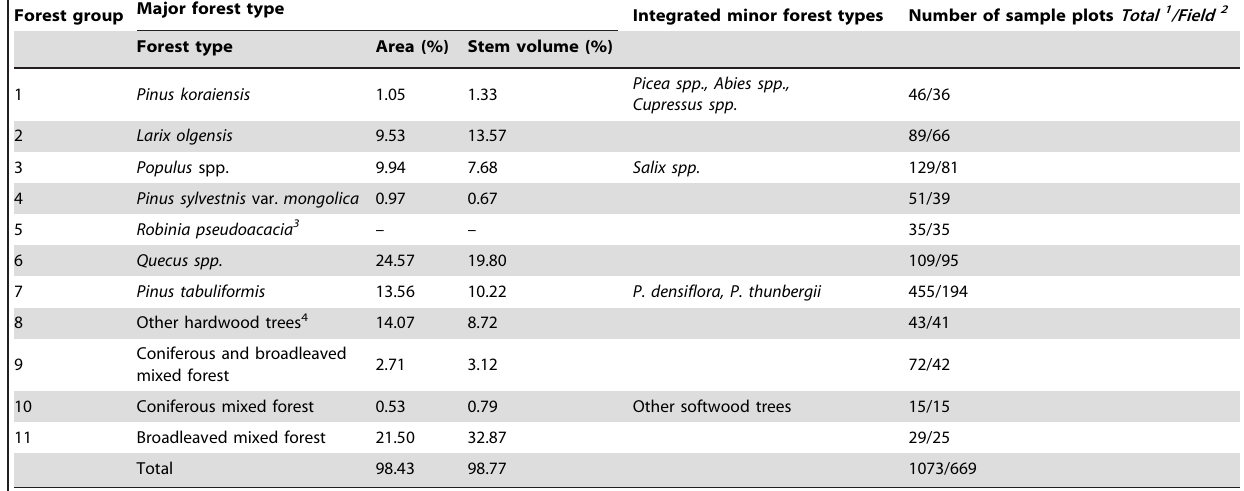
1 : Sum of plots established in this study for field data collection and plots described in published studies 2 : Plots established in this study for field data